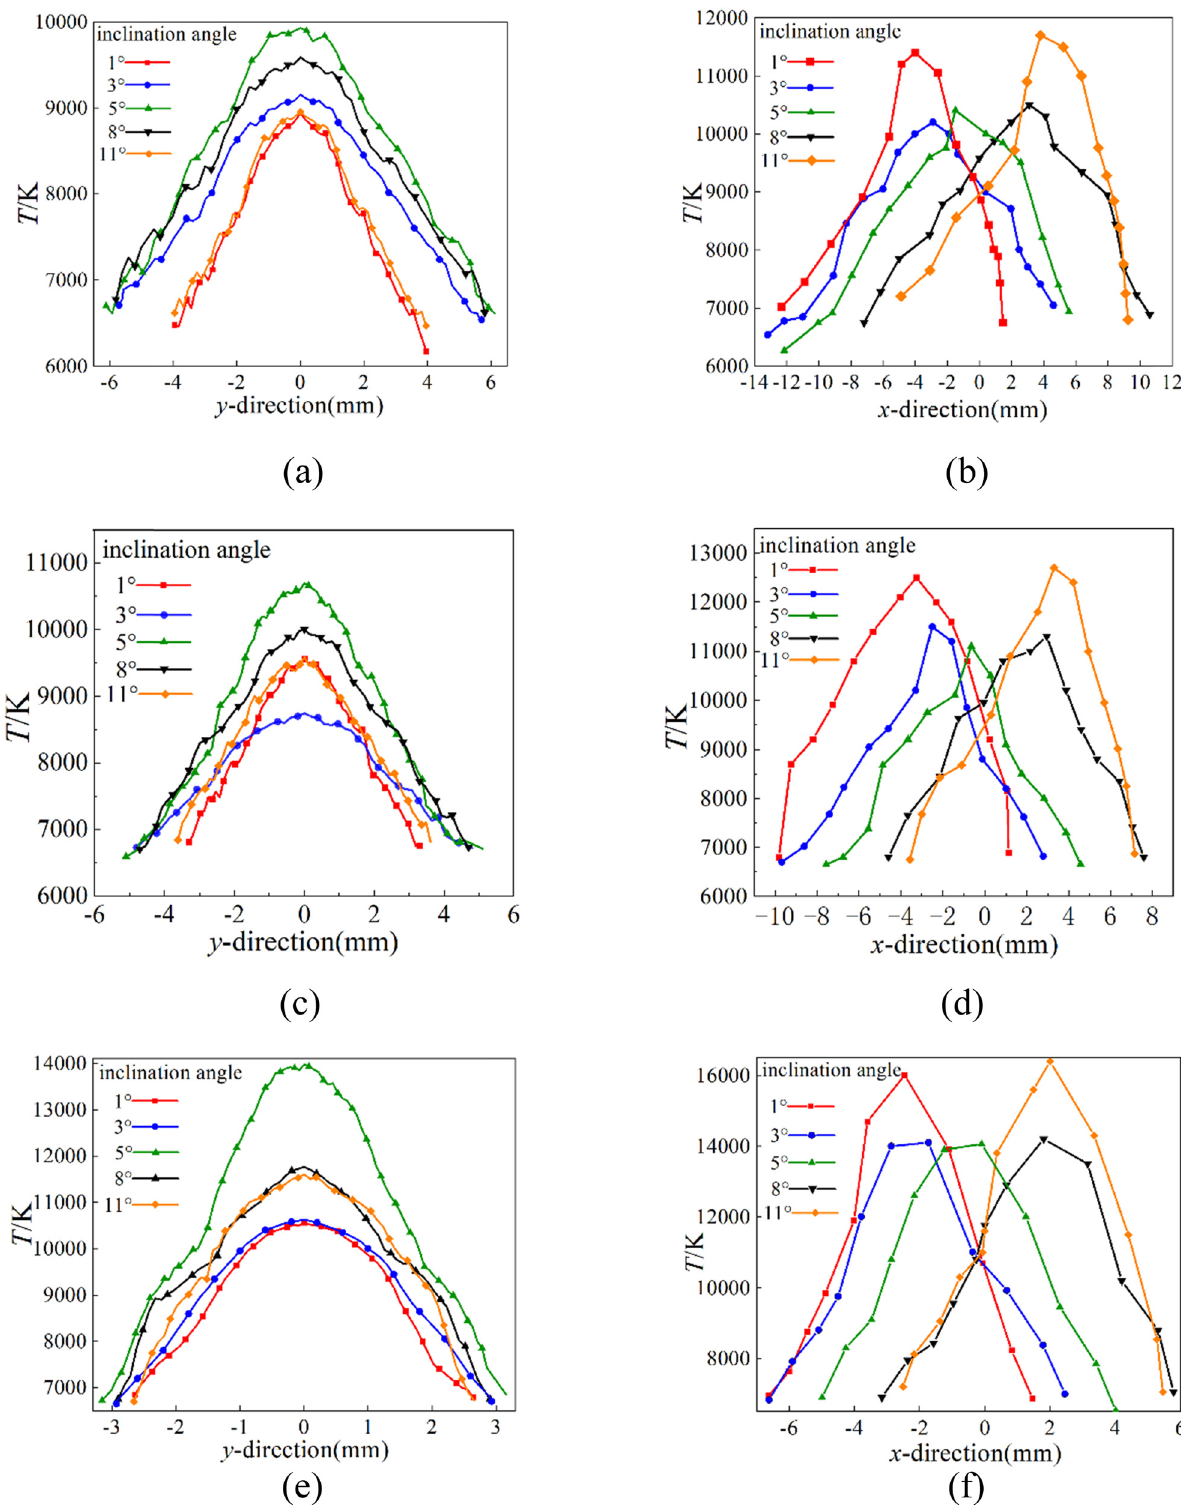
Figure 8: T distribution of arc current - carrying region with the di ff erent tilt angle of sheet slanting tungsten electrode hypotenuse. ( a ) T distribution in y - direction, z = 1 mm. ( b ) T distribution in x - direction, z = 1 mm. ( c ) T distribution in y - direction, z = 2.5 mm. ( d ) T distribution in x - direction, z = 2.5 mm. ( e ) T distribution in y - direction, z = 4 mm. ( f ) T distribution in x - direction, z = 4